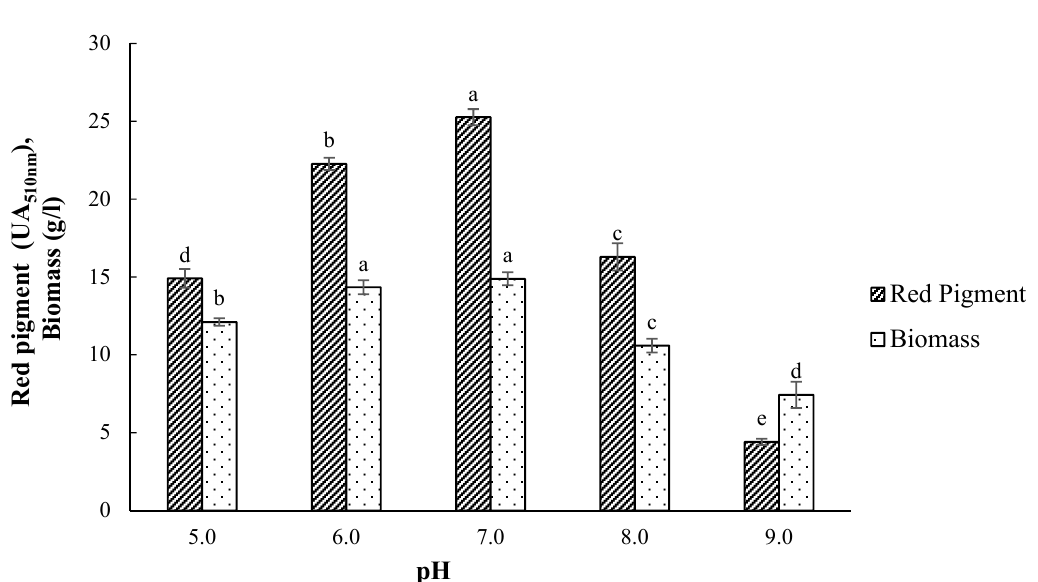
Figure 3. The effect of initial pH on the red pigment and biomass production by M. purpureus CMU 001 (Fermentation conditions: 30 °C, 8 days, 200 rpm, 5 g/L MSG, 50 g/L lactose).